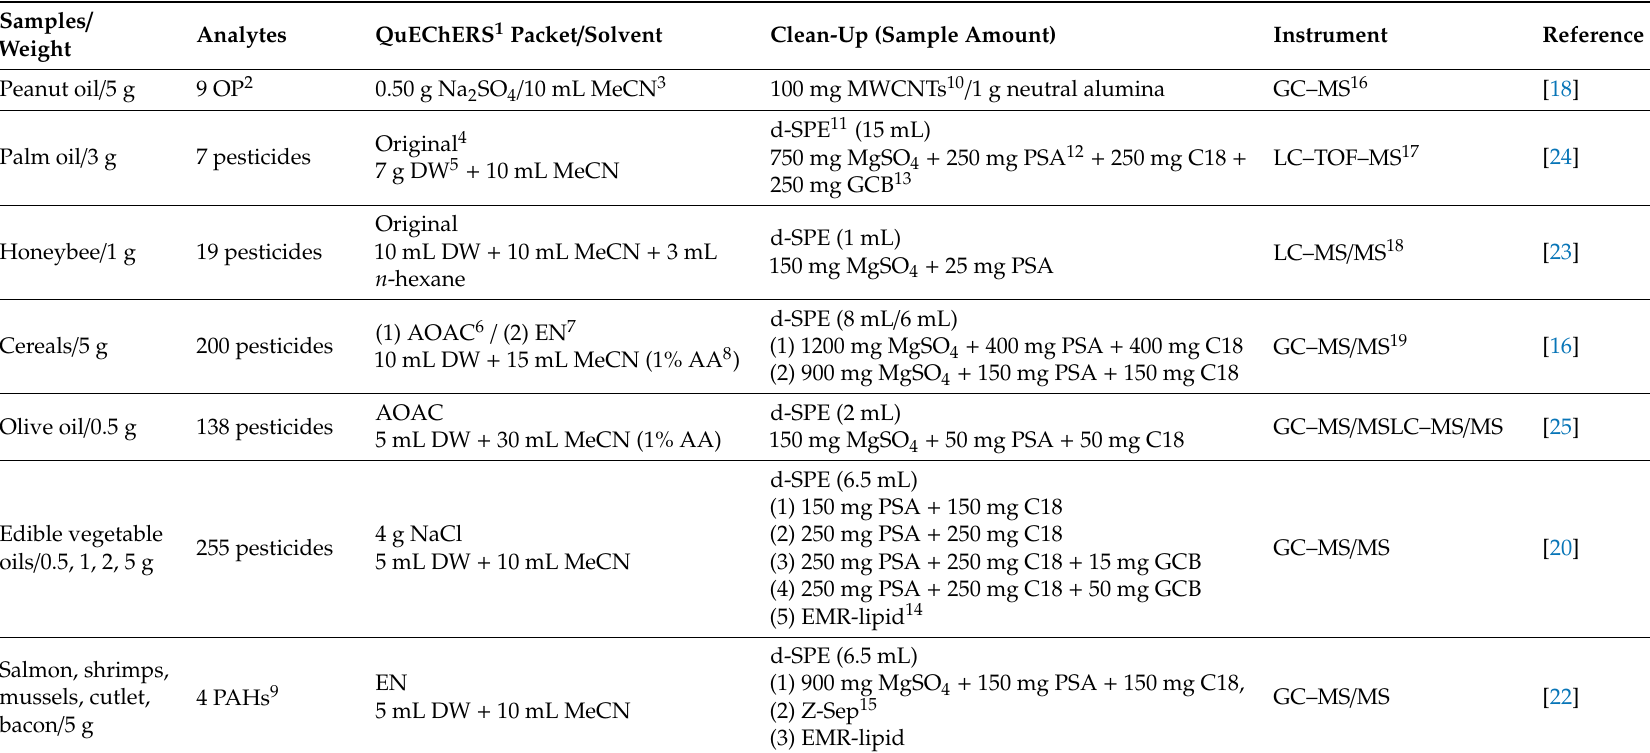
Table 1. List of studies which used various clean-up sorbents to remove lipids from the samples with high fat